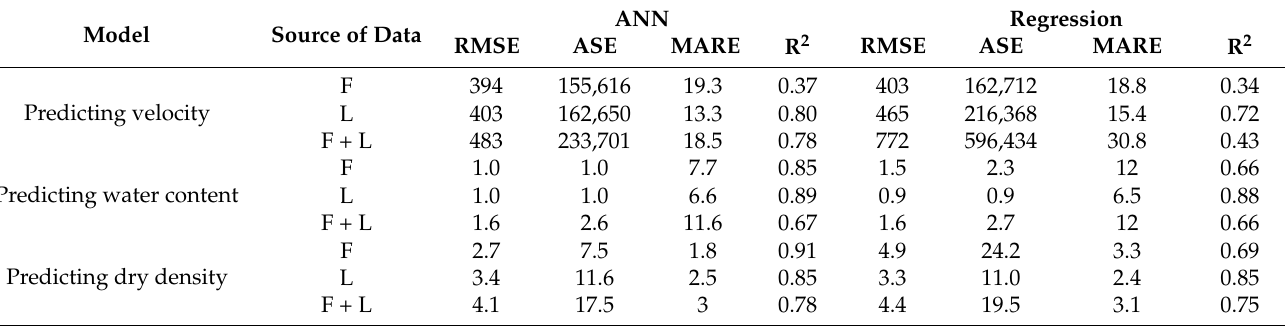
Table 7. Comparison of ANN and regression